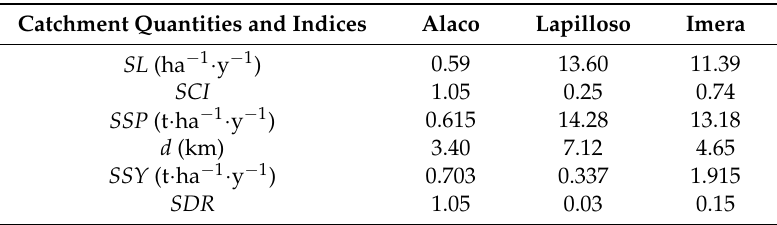
Table 2. Mean soil loss ( SL ), connectivity indices ( SSP and SCP ), mean sediment source distance from outlet ( d ), mean specific sediment yield ( SSY ) and sediment delivery ratio ( SDR ) of selected